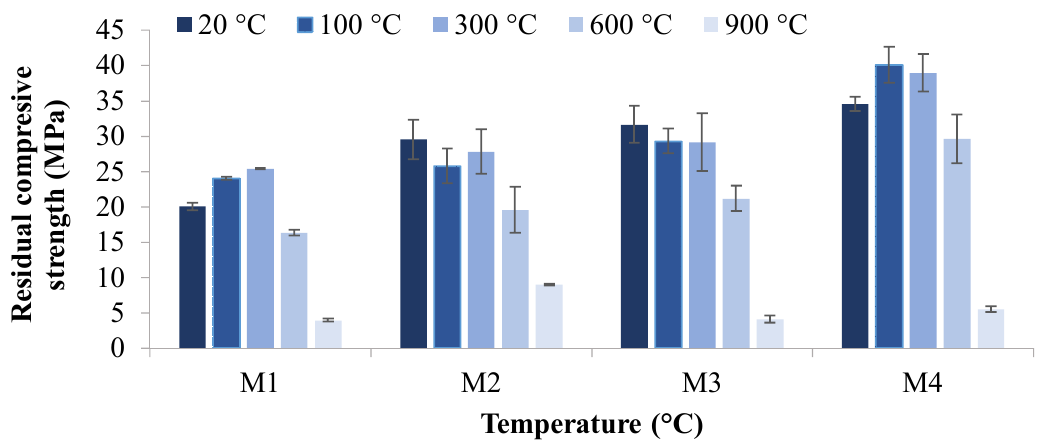
Figure 4. Residual compressive strength versus temperature after seven days.